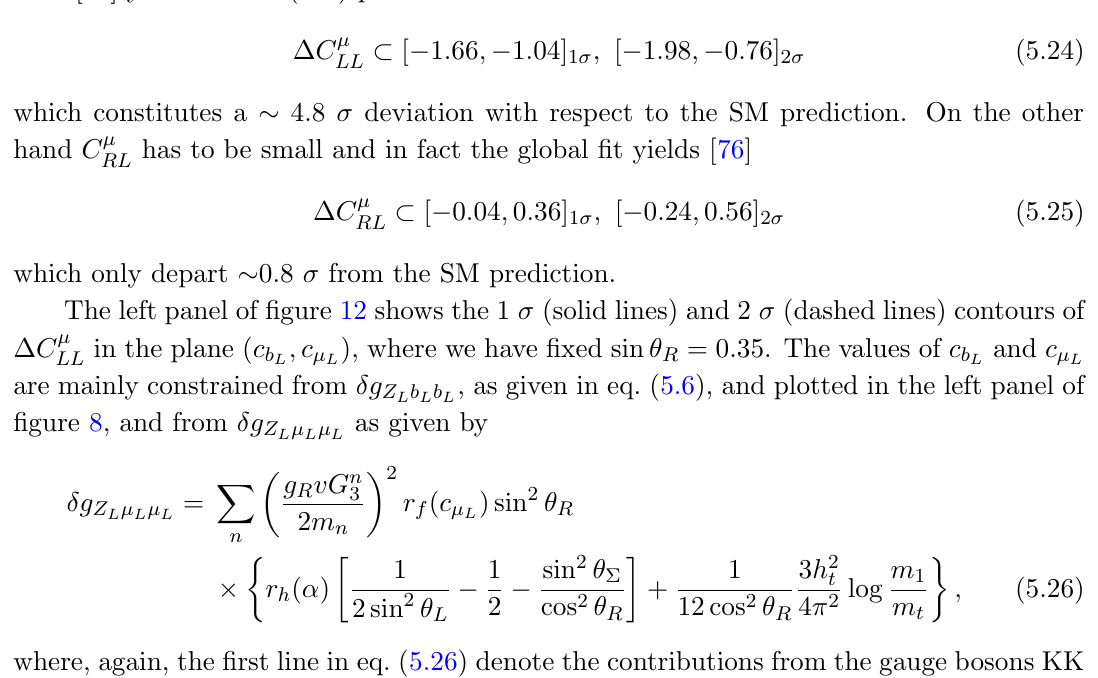
Figure 12 . Left panel: contour lines of constant (cid:1) C (cid:22) 1 (cid:27) (solid lines) and 2 (cid:27) (dashed lines) level as de(cid:12)ned in eq. (5.24). The value of sin (cid:18) R = 0 : 35 has been (cid:12)xed. Right panel: contour lines of constant (cid:1) C (cid:22) the upper bound on j ( V y ) 23 j ’ 0 : 005 obtained in eq. (4.32). In both panels the shaded yellow area d R corresponds to the excluded area obtained in (cid:12)gure